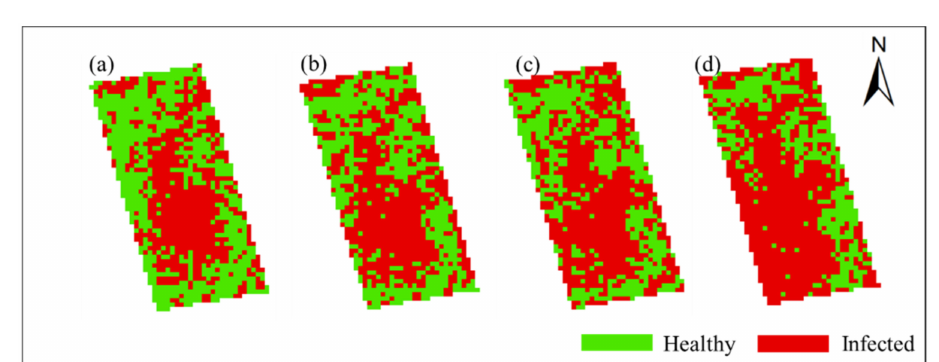
Figure 10. Spatiotemporal distribution of occurrence information of rice false smut in Plot